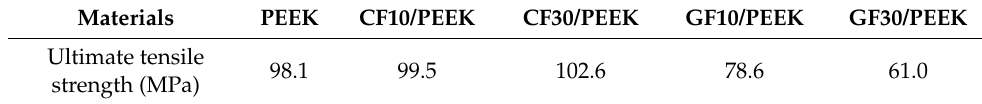
Table 3. The ultimate tensile strength of the pure PEEK and fiber-reinforced PEEK materials. Materials